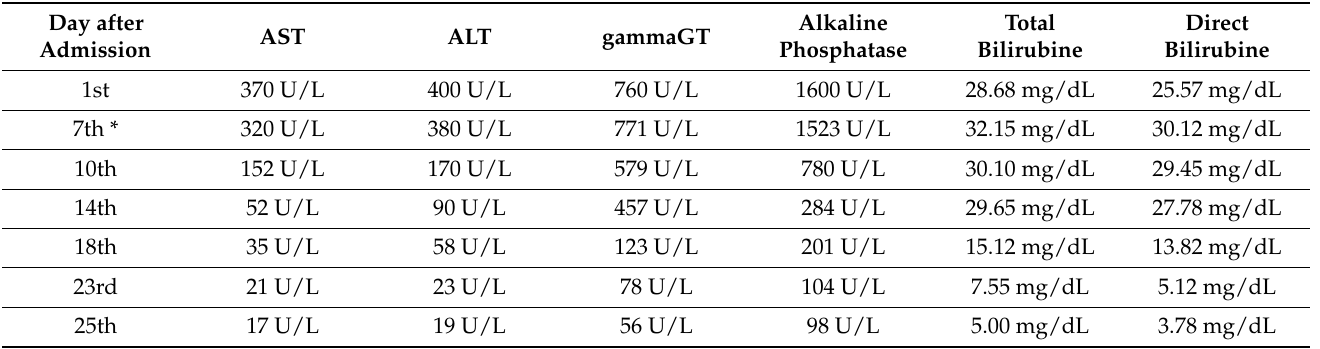
Table 1. Trend of LFTs during